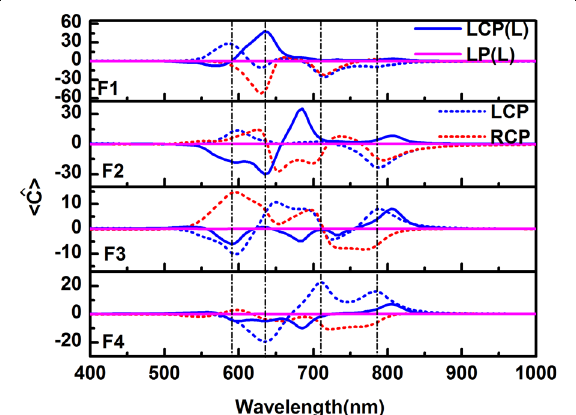
Fig. 9 Volume-averaged optical chirality enhancement factors in the gaps F1, F2, F3, and F4 indicated in the insets of Fig. 8. The blue and pink solid lines represent the volume-averaged chiral near-field enhancement spectra of the linear structure excited by left-hand circle light (marked as LCP (L)) and linear polarized light (marked as LP (L)), respectively. The blue and red dotted lines represent the volume-averaged chiral near-field enhancement spectra of the chiral silver particle chain-film for LCP and RCP light, respectively. The vertical dashed lines from left to right correspond to the peaks at 590, 635, 710, and 785 nm,